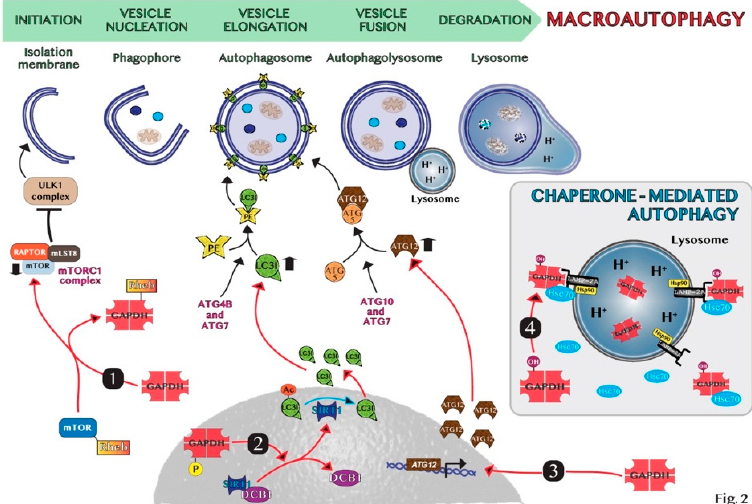
Figure 2. Schematic representation of molecular mechanisms of GAPDH-mediated autophagy: (1) GAPDH binds to Rheb, preventing Rheb binding to mTOR. (2) Phosphorylated GAPDH by AMPK translocates into the nucleus and disruptions the link between SIRT1 and DBC1. SIRT1 deacetylates LC3, which sustains autophagosome formation. (3) GAPDH enters the nucleus, favoring the induction of ATG12 gene. (4) In chaperone-mediated autophagy (CMA), GAPDH binds to LAMP-2A receptor on the lysosomal membrane. The chaperon proteins hsc70 and hsp90 are essential for CMA activity. Cytosolic Hsc70 after binding to CMA-substrates, such as GAPDH, transfers the complex to LAMP-2A. Hsp90 stabilizes LAMP-2A at the luminal side of the lysosomal membrane for the translocation of